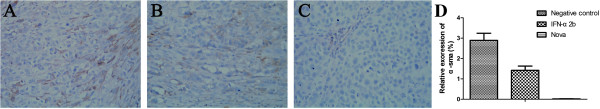
α-SMA protein levels in groups of IFN-α2b (B) and Nova (C) compared with the negative control (A) by immuno histochemical analysis. D is quantization of the expression of the proteins evaluated in the different samples with immunohistochemistry.